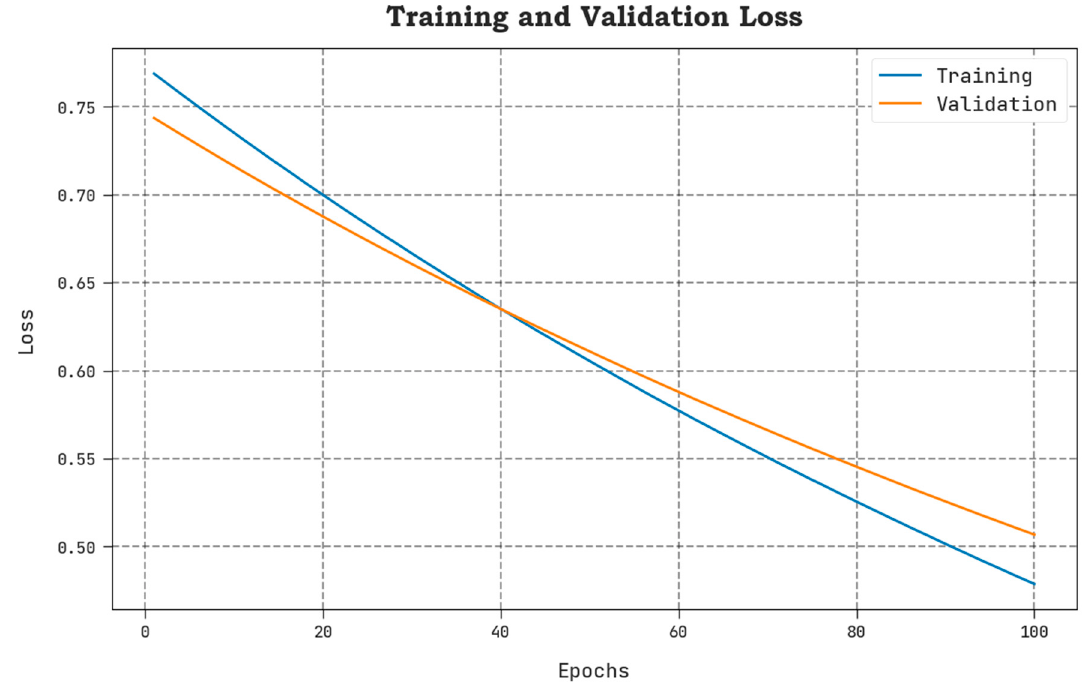
Figure 8. TLOS and VLOS analysis of AAOXAI-CD approach on dataset-1.